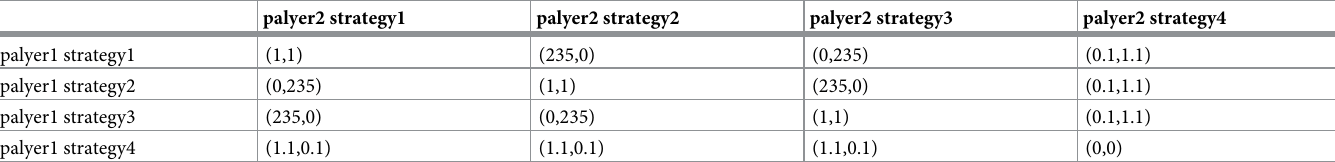
Table 2. Two-person zero-sum game payment